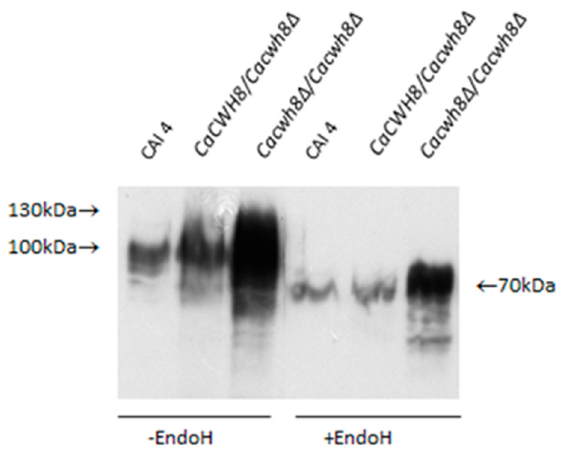
Figure 8. N -glycosylation of Phr1p protein in the wild type C. albicans strain CAI4 and the CaCWH8 mutants. Proteins (100 µg) extracted from indicated strains were electrophoretically resolved, transferred to an Immobilon-P membrane, and probed with monoclonal anti- S. cerevisiae Gas1p antiserum.